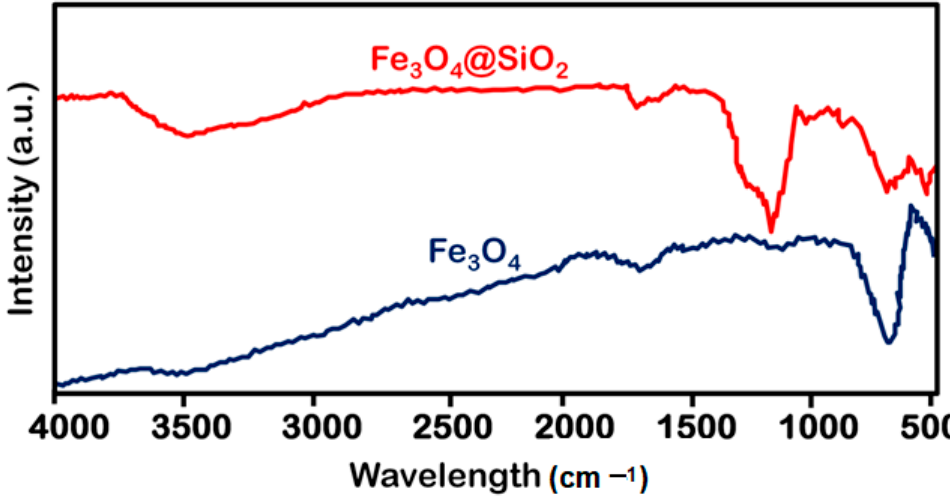
Figure 3. FTIR spectra of Fe 3 O 4 NPs and Fe 3 O 4 @SiO 2 MNPs.